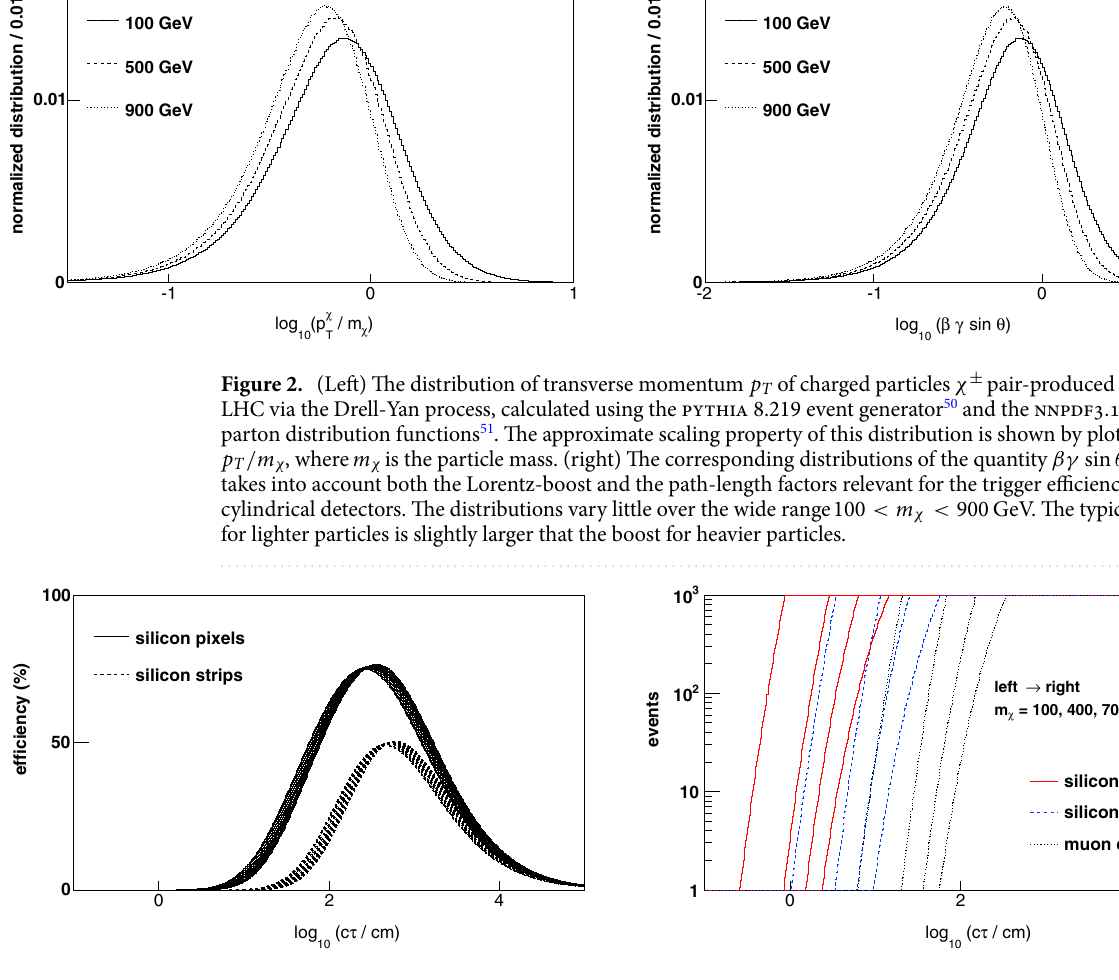
Figure 3. (Left) The effective trigger efficiencies (averaged over the boost spectrum) as functions of the proper decay distance c τ for a range of masses 100 < m χ < 1000 GeV, showing the small dependence on m χ . The difference between the spectrum-convolved efficiency of a pixel- or strip-based trigger, and the same for a muon-based trigger, is shown. The efficiency gain curves are shifted to lower values of c τ for lower values of m χ . (right) Based on the effective trigger efficiencies, the number of events observable for an integrated luminosity of 3 ab − 1 at the HL-LHC is shown as a function of c τ for pair production of supersymmetric partners of leptons. For each trigger system, the four curves (from left to right) correspond to supersymmetric lepton masses of 100, 400, 700 and 1000 GeV